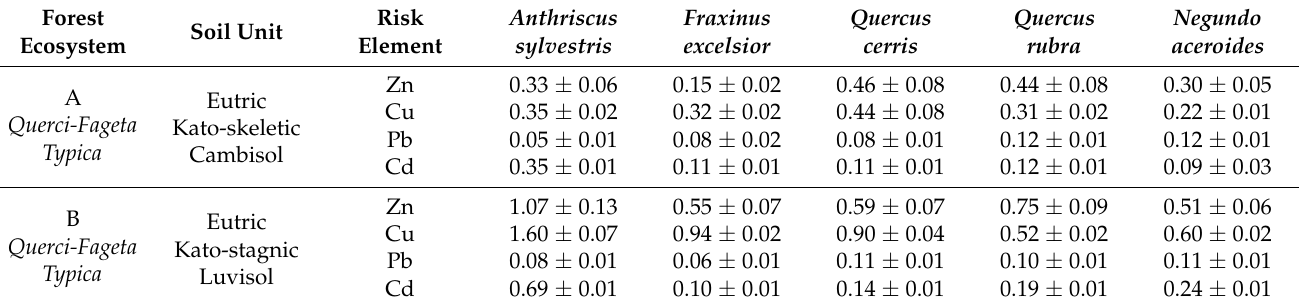
Table 5. Transfer coefficients of trace elements found for foliage of studied plant species.